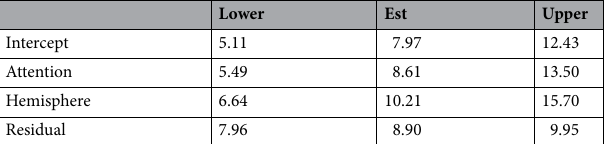
Table 4. Approximate 95% confidence intervals for the standard deviation of a random intercept, random slopes for attention and hemisphere, and a